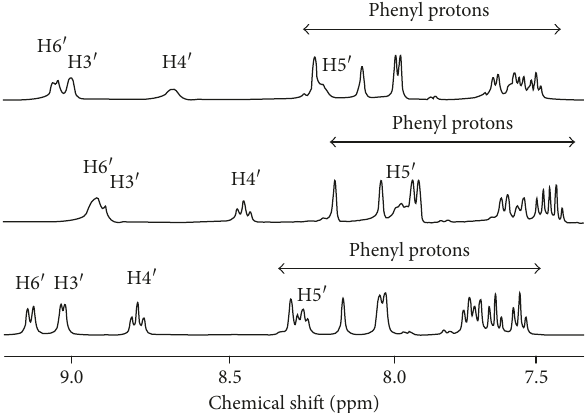
Figure 4: 1 H NMR spectrum of ferrozine (bottom) and complexes 3 (middle) and 4